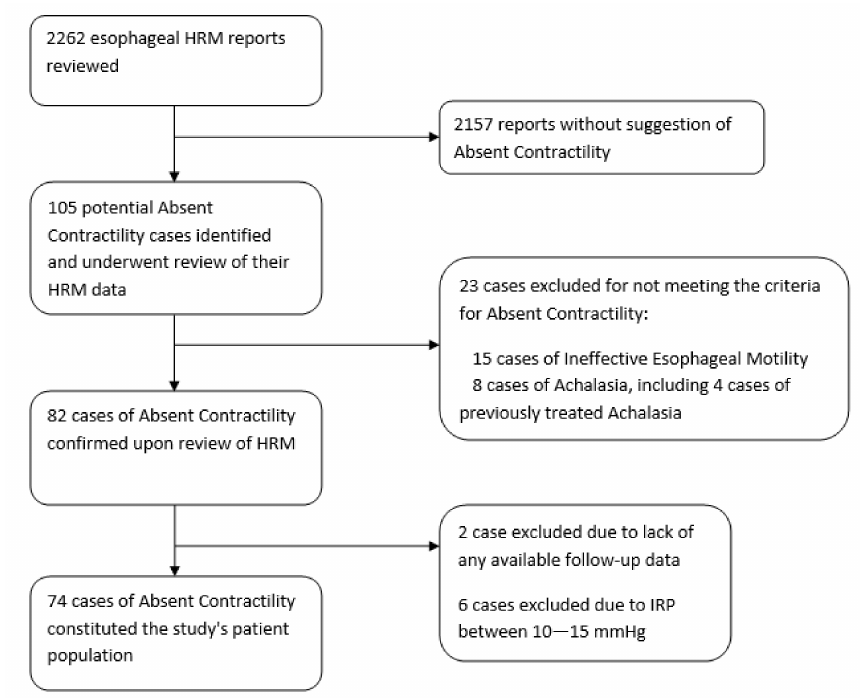
Figure 1. Flowchart of absent contractility